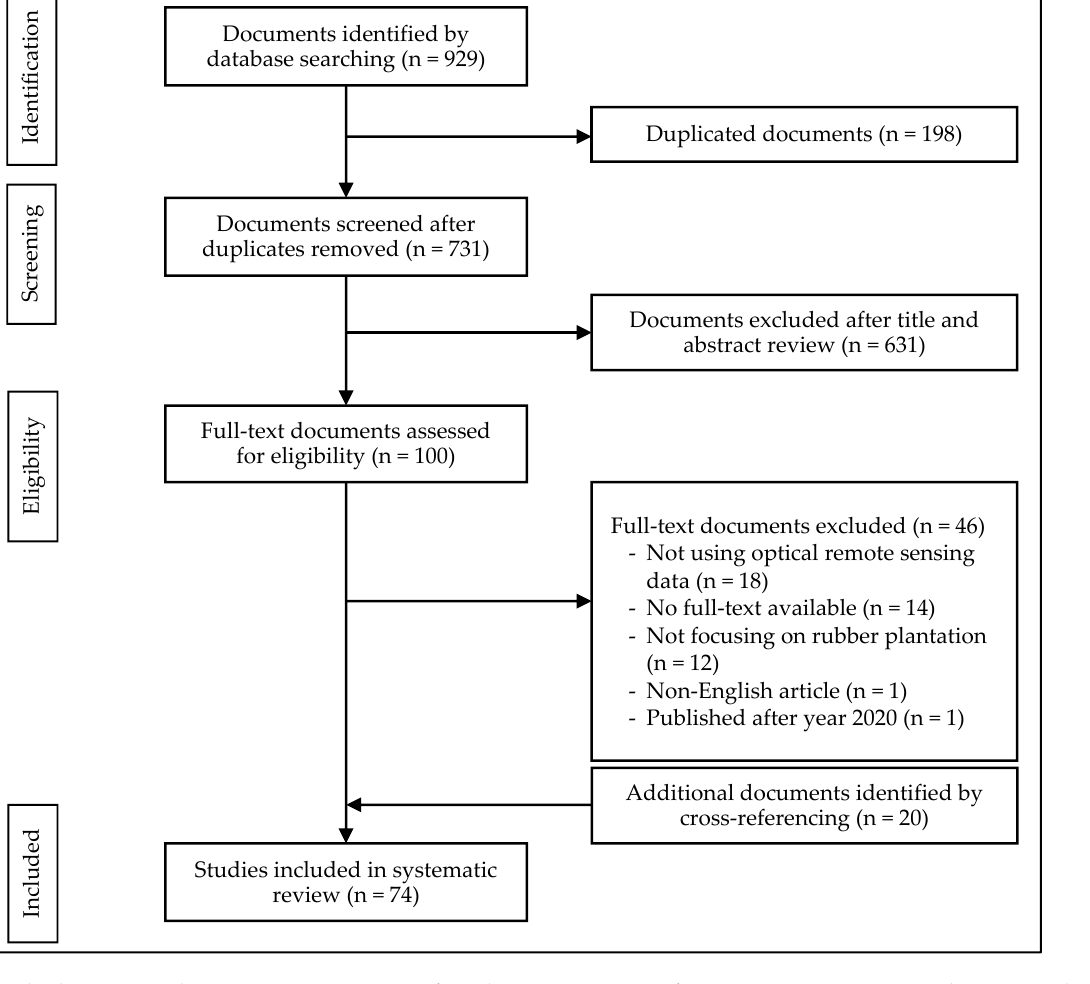
Figure 1. The literature selection process using Preferred Reporting Items for Systematic Reviews and Meta-Analyses (PRISMA) framework.